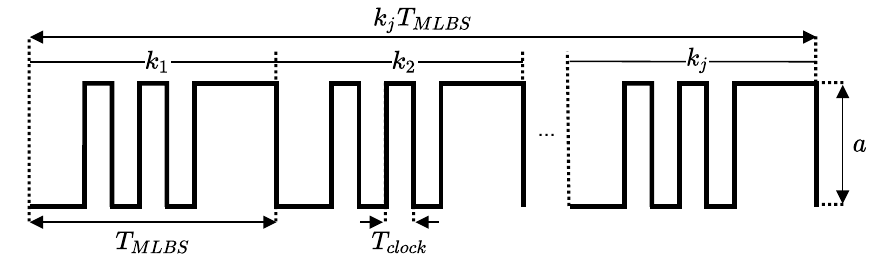
Figure 4. Generation of MLBS with the help of a shift